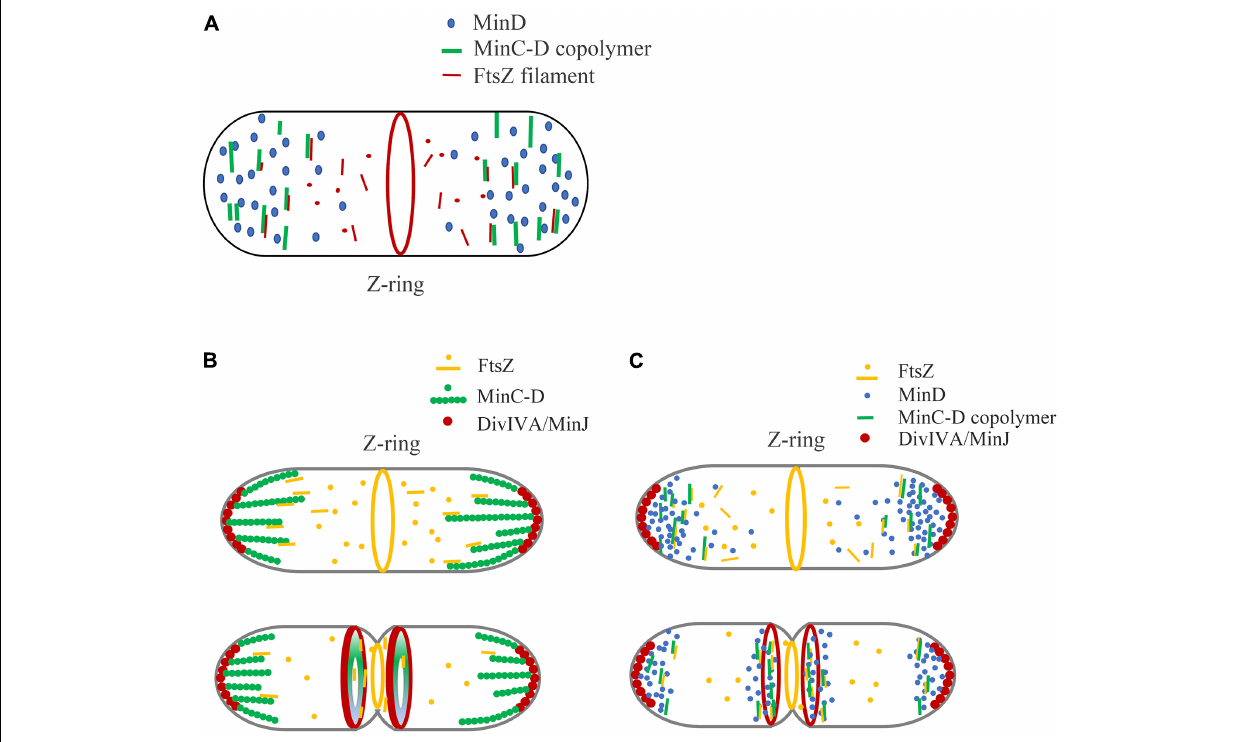
FIGURE 4 | A new model is proposed to explain the regulation of Min system on Z-ring assembly positioning, emphasizing the role of MinC-D copolymer. (A) In general, we think that the binding of MinC-D copolymer to FtsZ protofilament is the key to Z-ring localization regulation. MinC will coassemble with MinD in the area of high concentration of MinD. The tight binding between MinC-D copolymers and FtsZ filaments not only greatly enhances the binding coefficient between MinC and FtsZ subunits, but also can capture FtsZ protofilaments, and prevent their diffusion to the ends of the cell. This may occur in both MinCDE and MinCDJ systems. (B,C) Show our new model of how Min proteins regulate Z-ring position in B. subtilis , if Min proteins form stable structures (B) or dynamic structures (C) . Whether MinC/MinD/DivIVA/MinJ complex is stable or dynamic in vivo is controversial. The location of DivIVA determines the uneven distribution of MinD proteins: at the early stage of division, MinD is only located at both ends of the cell, and when membrane invagination begins, MinD accumulates both at the cell poles and midcell. MinC-D copolymers are formed in the area of high concentration of MinD, and form a relatively stable complex (B) or dynamic complex (C) with DivIVA and MinJ. If the complex is dynamic, MinC-D copolymers can be released from DivIVA and accumulated near DivIVA/MinJ complex. This protein complex, when located at the ends of the cell, prevents FtsZ from diffusing to the ends of the cell. And when it is in the middle, this complex can further restrict the Z-ring to a narrow area in the middle. After the MinC-D copolymers and FtsZ protofilaments are tightly combined, MinC accelerates the depolymerization of FtsZ